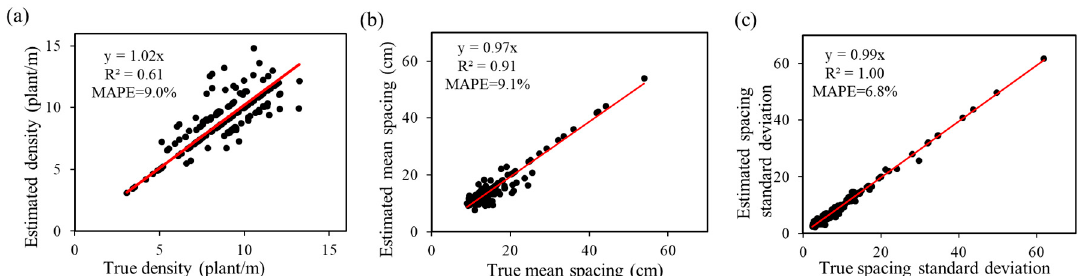
Figure 11. Fitness between manually measured and estimated plant density ( a ) and uniformity that described as plant mean spacing ( b ) and plant spacing standard deviation ( c ).